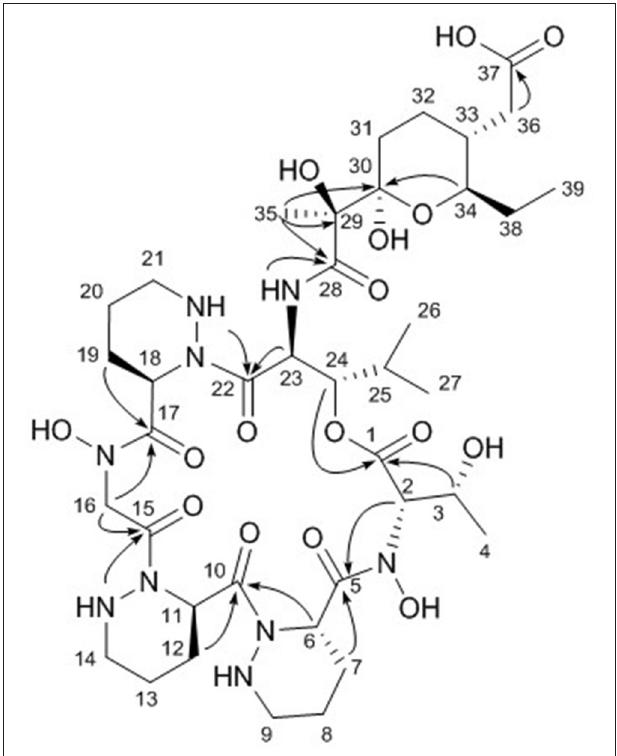
FIGURE 2 | Structures of dentigerumycin E ( 1 ) and its derivatives ( 2 and 3 ).